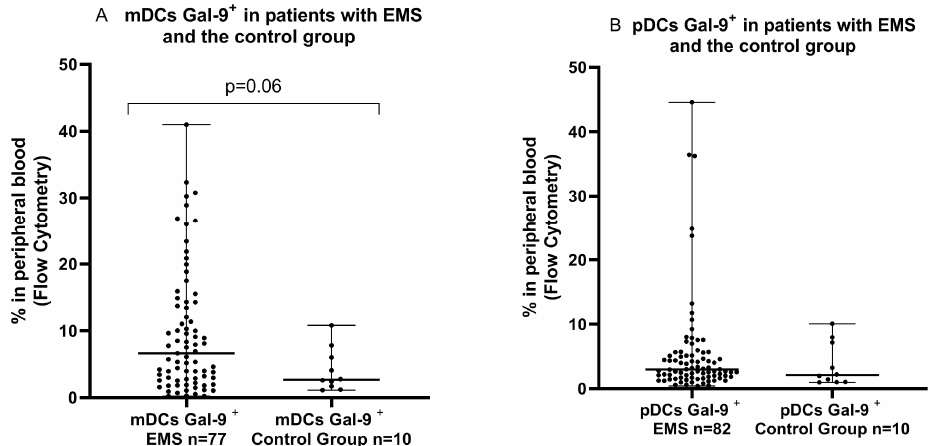
Figure 2. Percentage of mDCs Gal-9-positive ( A ) and pDCs Gal-9-positive cells ( B ) in peripheral blood in patients with endometriosis and control group.